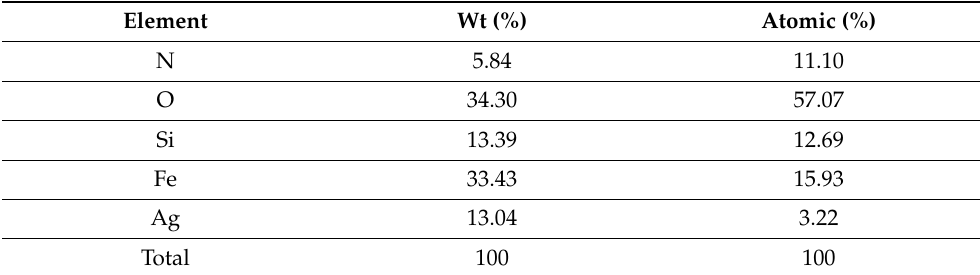
Table 1. Component ratio of mag@silica-Ag by EDS.